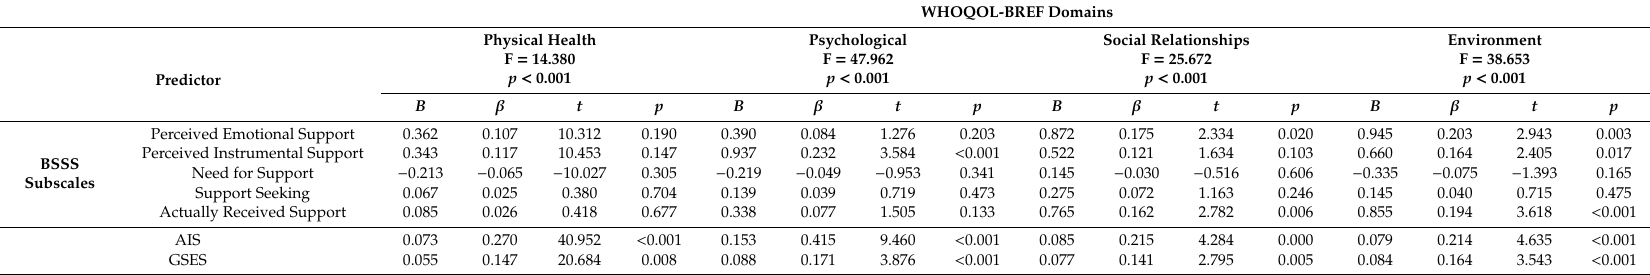
Table 7. Regression analysis for WHOQOL-BREF domains and BSSS, AIS, and GSES scores in the hyperglycemic pregnant women studied.